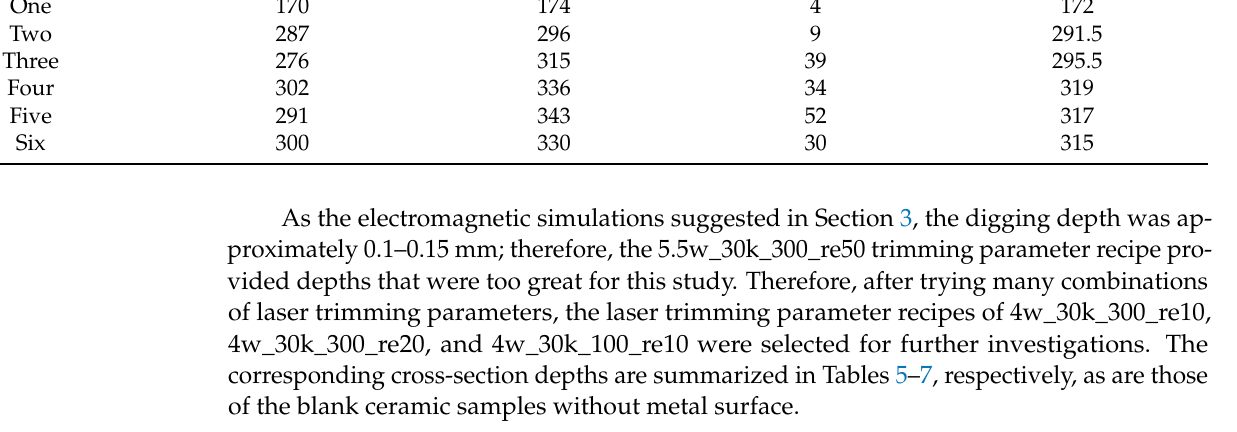
Table 5. The measured depth values after different numbers of repeated laser firings with the 4w_30k_300_re10 recipe. Number of Repeated Laser Firings